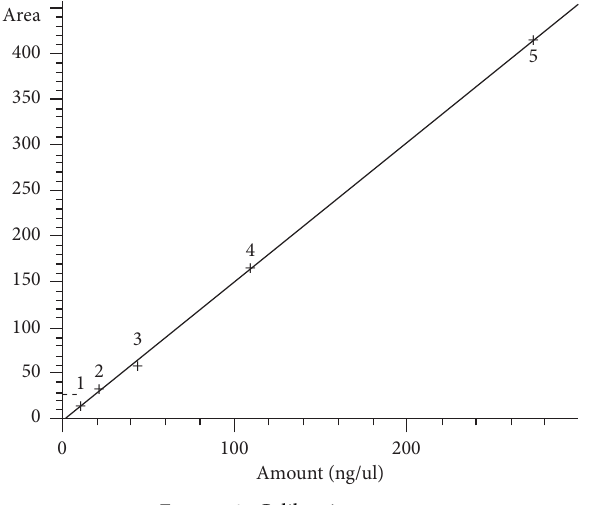
Figure 3: Calibration